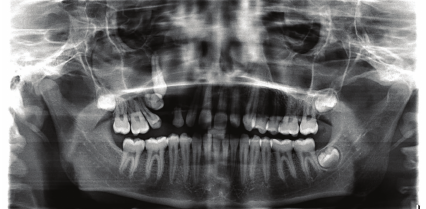
Figure 4: Panoramic radiograph showing impacted 13, 14.